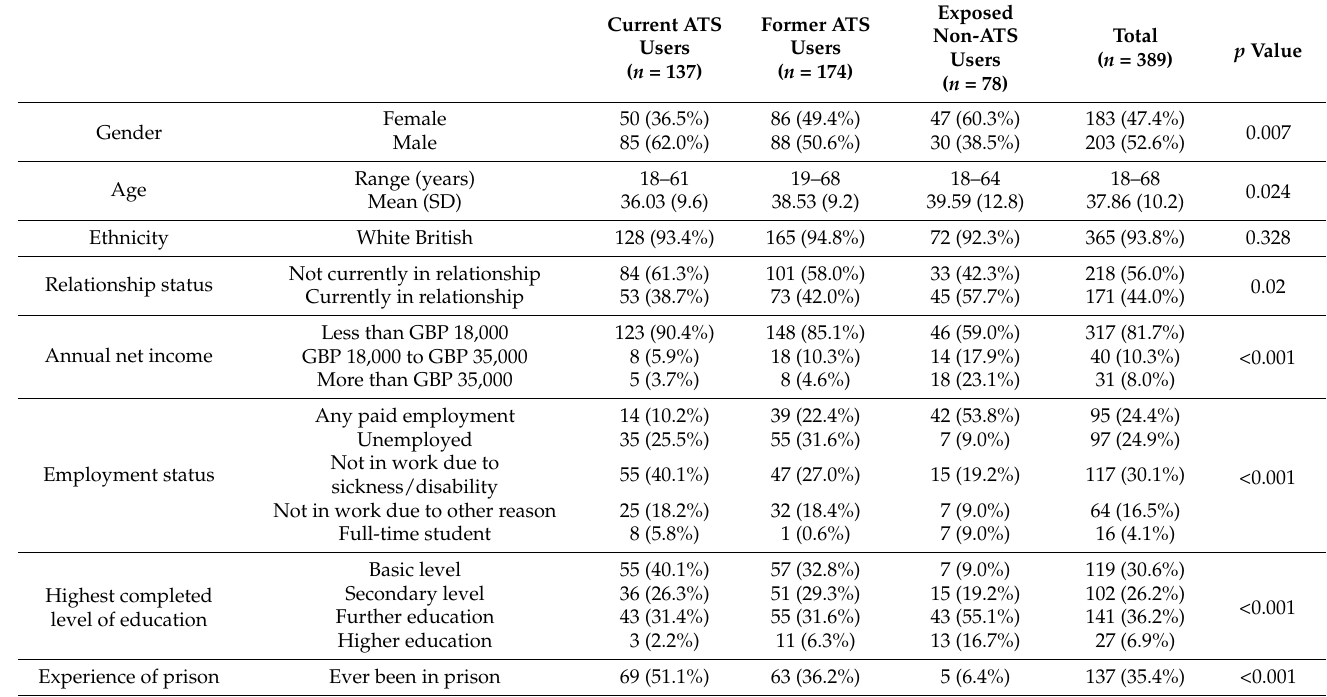
Table 1. Demographic information for survey participants by study